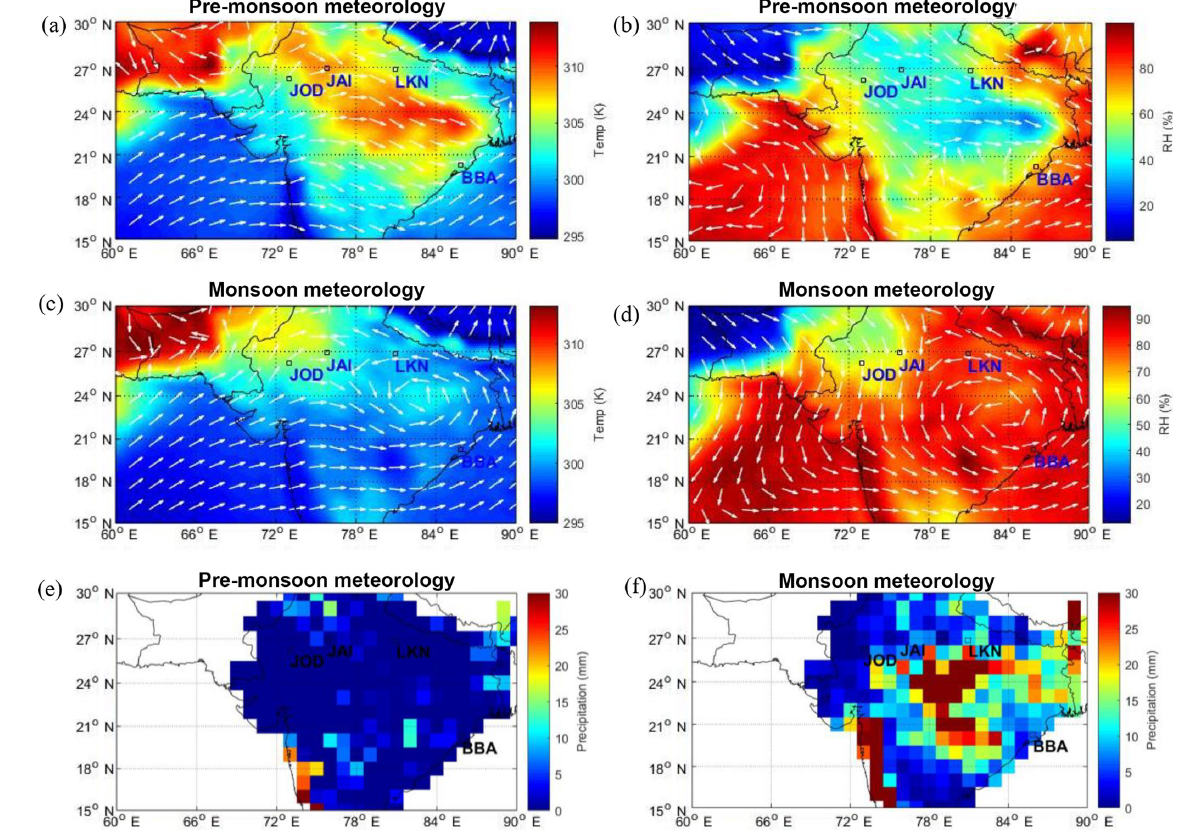
Figure 2. Mean meteorological conditions in the boundary layer (950hPa pressure altitude) ( a and c ) and aloft (650hPa pressure altitude) ( b and d ) for the pre-monsoon and monsoon flights. The wind direction is displayed using white arrows on each of the plots, with temperature (Kelvin) and relative humidity (%) indicated with the colour scale. The data used in the maps are from ERA-Interim (Dee et al., 2011). Panels (e) and (f) present 1 ◦ gridded precipitation (mm) data based on 2140 weather stations over India, again for the pre-monsoon and monsoon flights, from the Indian Meteorological Department